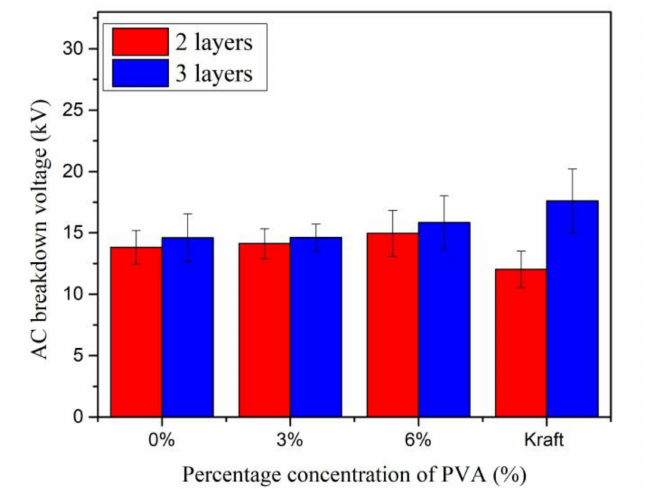
Figure24. ACBreakdownvoltageofKenafandKraftpapersatdi ff erentweightpercentageconcentration of PVA.